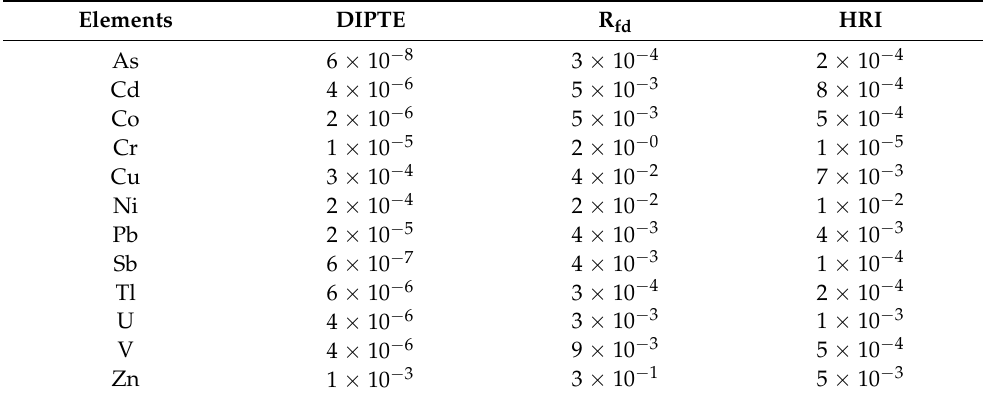
Table 4. Values of the Daily Intake (DIPTE, mg/kg/day), reference dose (R fd , mg/kg/day), and Health Risk Index (HRI) for each PTE in bulbs of elephant garlic from the Valdichiana area. Elements